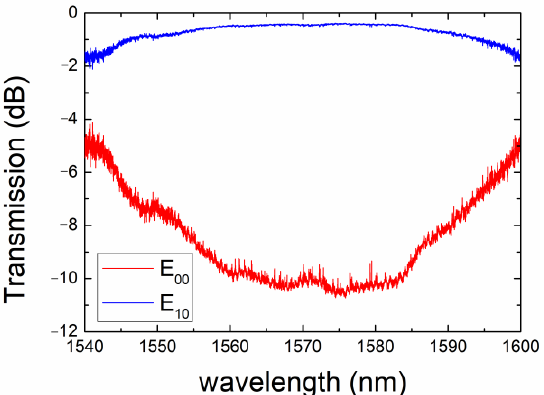
Figure 11. Measured transmission spectrum of fabricated mode converter in 1540–1600 nm.